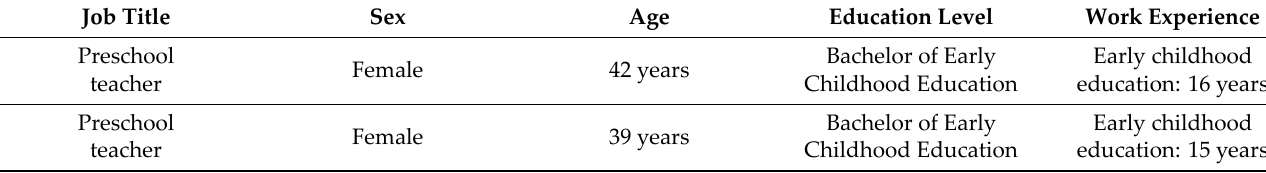
Table 3. Practitioners of local culture